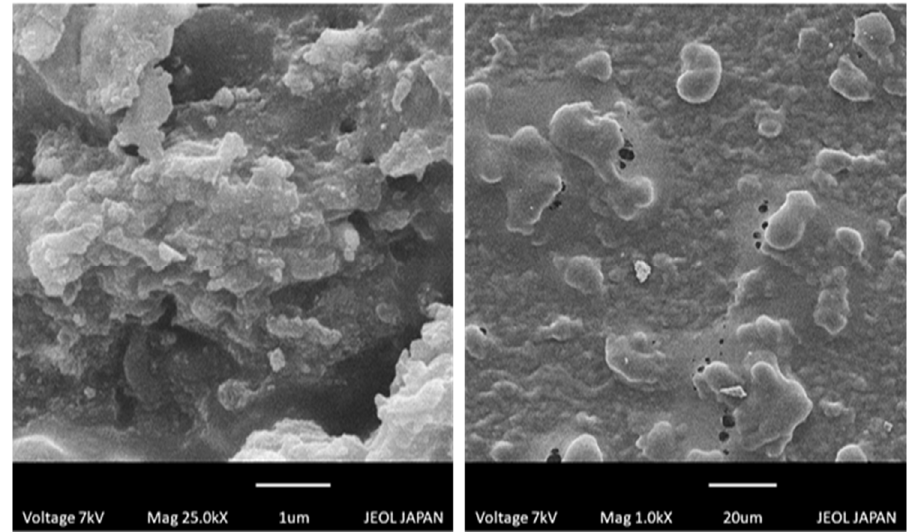
Figure 7. SEM photomicrographs of Na-CMC/pectin-co-poly (methacrylic acid) hydrogel .